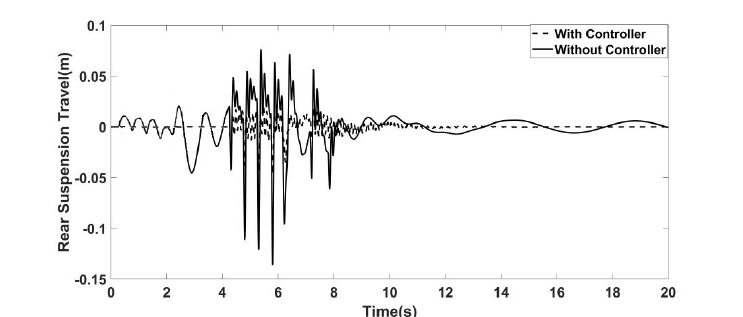
Figure 14. Rear Body